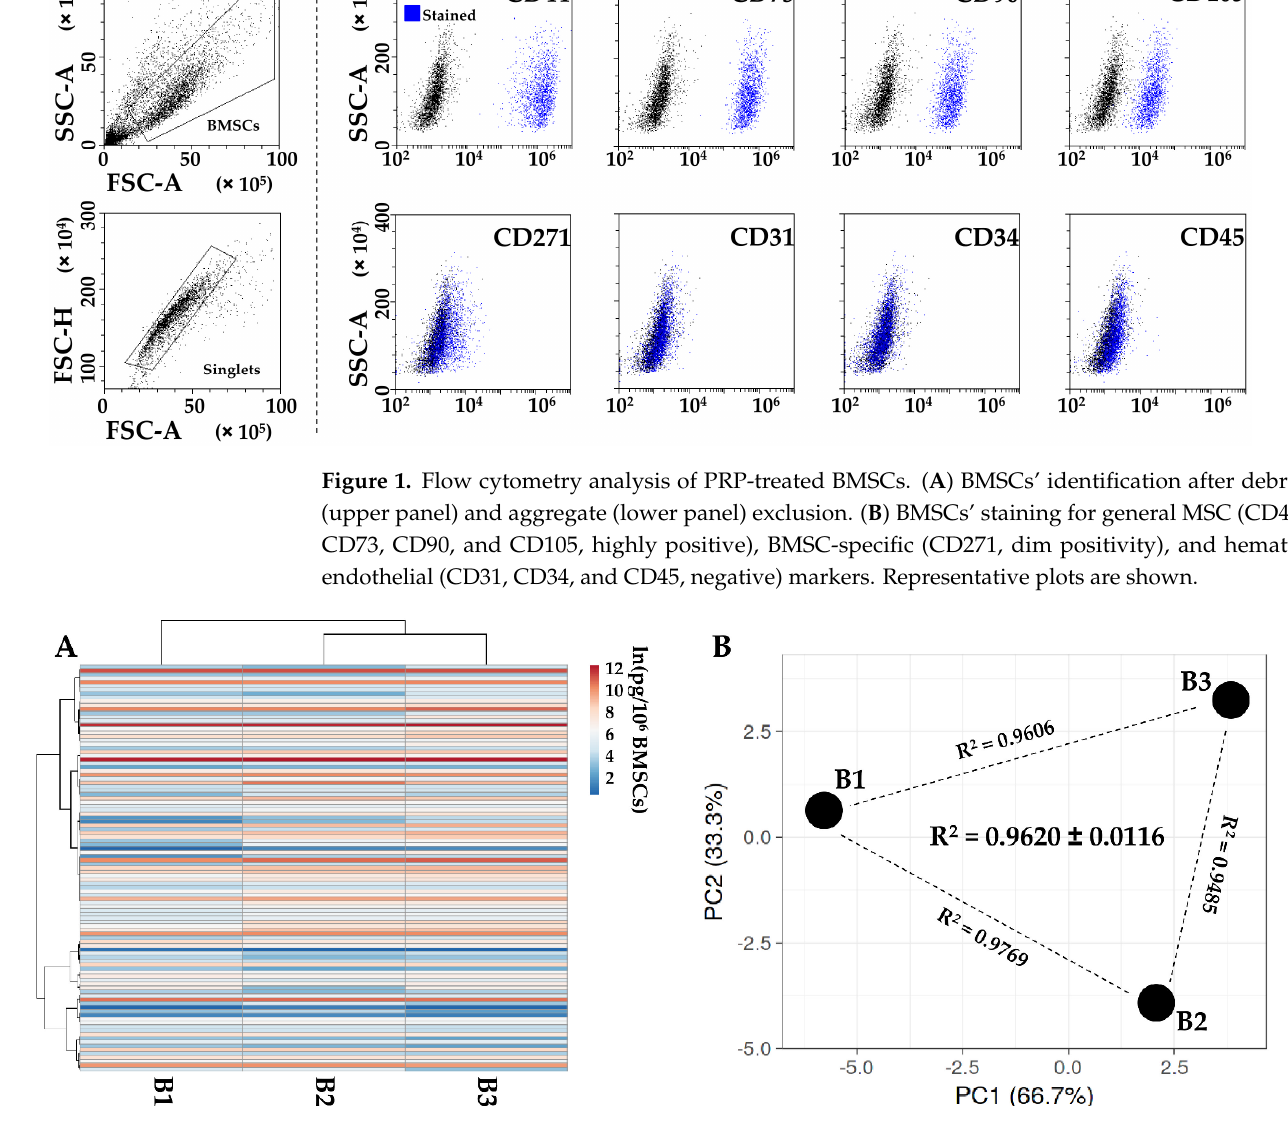
Figure 2. Secreted factor profile comparison between PRP-treated BMSCs under study. A, heat map of hierarchical clustering analysis of the ln(x)-transformed pg/million BMSCs values of detected factors with sample clustering tree at the top. Absolute expression levels reflect the color scale: red shades = high expression levels and blue shades = low expression levels. B, principal component analysis of the ln(x)-transformed pg/million BMSCs values of detected factors. X and Y axis show principal component 1 and principal component 2, which explain 62.5% and 37.5% of the total variance.